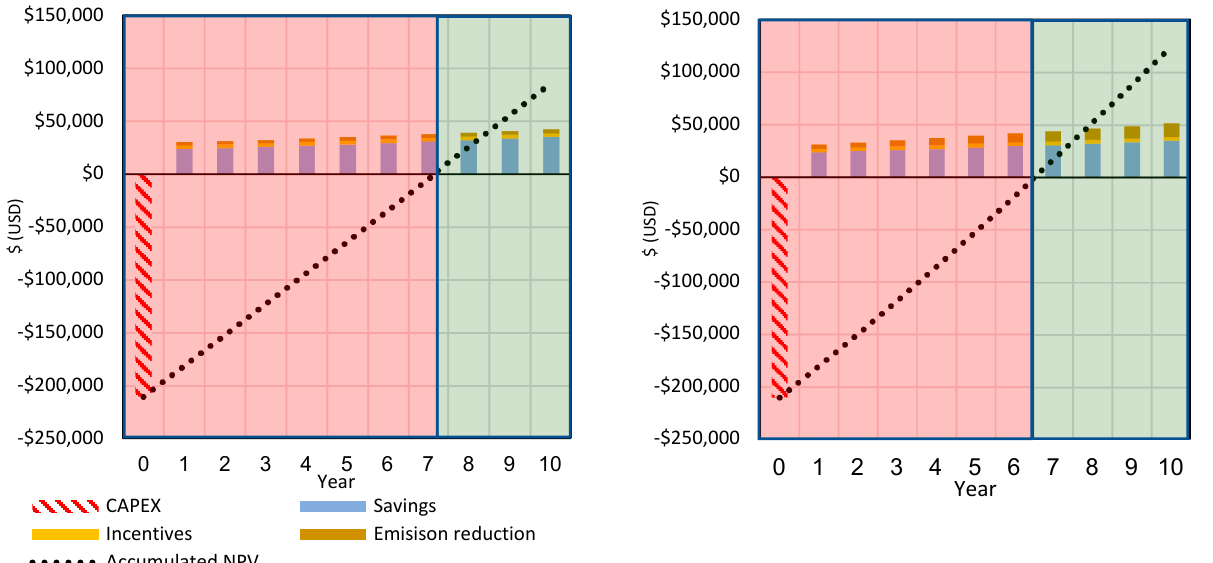
Figure 8. Cost − benefit scenarios for a project without ( left ) and with incentives ( right ) for renewable energy generation.